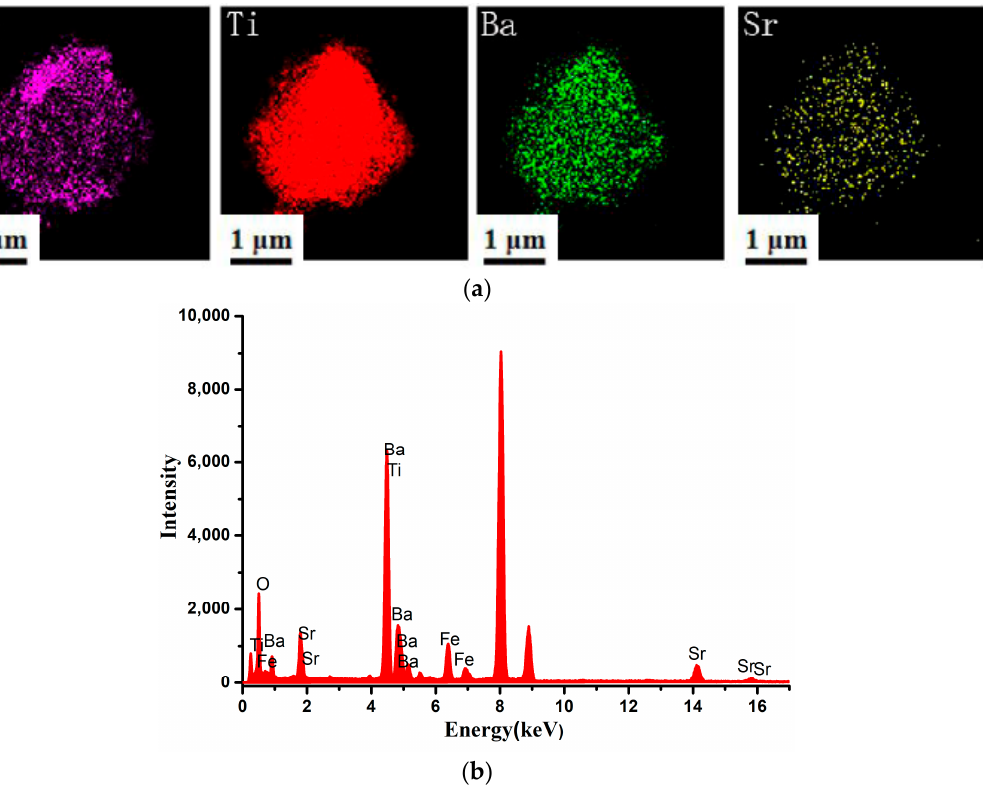
Figure 7. ( a ) Surface scanning elemental distribution and ( b ) EDS results of BST@ 10wt% Fe 2 O 3 .